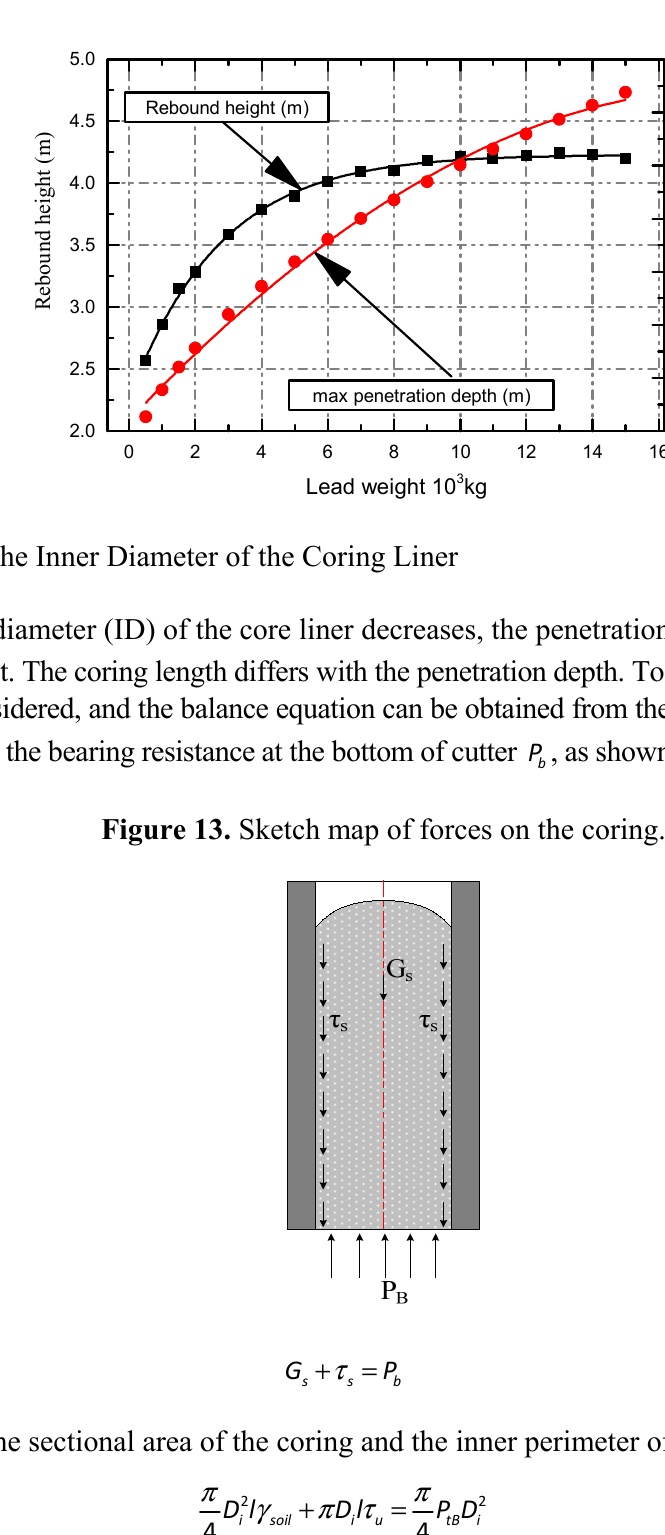
Figure 12. Variations of rebound height and maximum penetration depth vs. different lead weight.